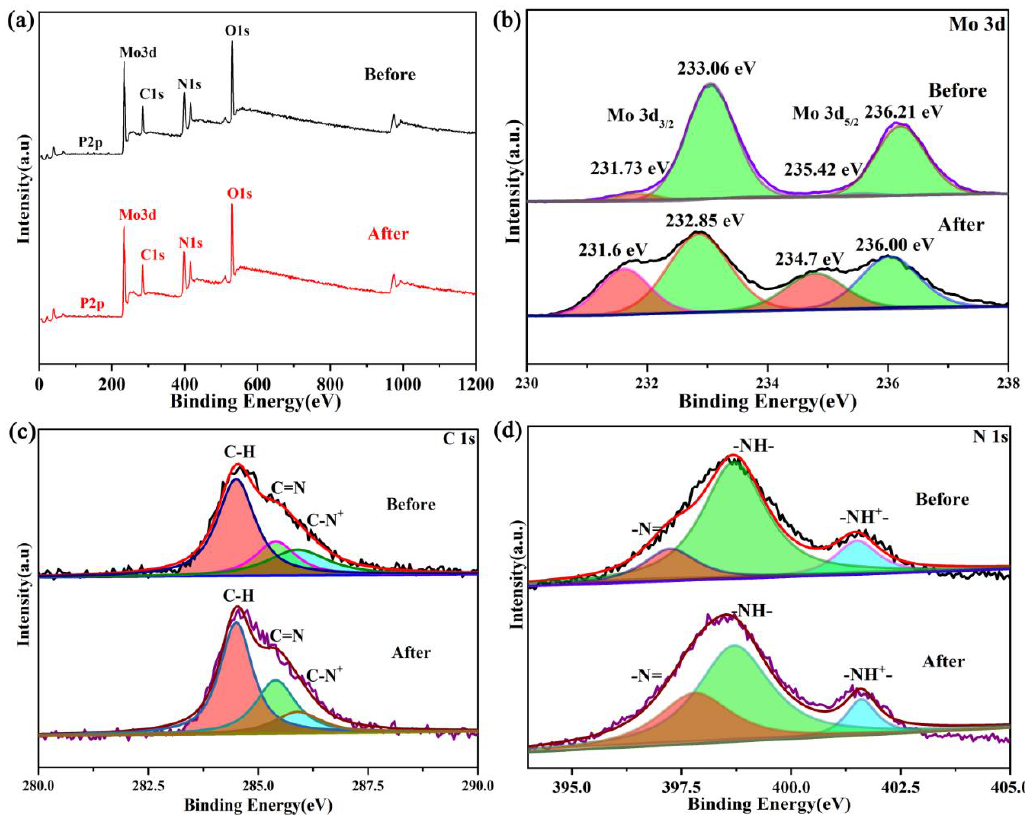
Figure 6. ( a ) XPS survey spectrogram of the PMoA / PANI hybrid thin film before and after optical-light illumination. ( b ) XPS survey spectrogram and Gaussian deconvolution curve fitting for Mo 3d in the PMoA / PANI hybrid thin film. ( c ) XPS survey spectrogram and Gaussian deconvolution curve fitting for C 1s in the PMoA / PANI hybrid thin film. ( d ) XPS survey spectrogram and Gaussian deconvolution curve fitting for N 1s in the PMoA / PANI hybrid thin film. Table 3. The change in the valence state of Mo in the PMoA / PANI hybrid thin film. Mo 5 + Mo 6 + Sample Mo 5 + / Mo Ratios 3d 3 / 2 3d 5 / 2 3d 3 / 2 3d 5 / 2 Before 231.85 235.50 233.05 236.20 0.07 After 231.65 234.80 232.90